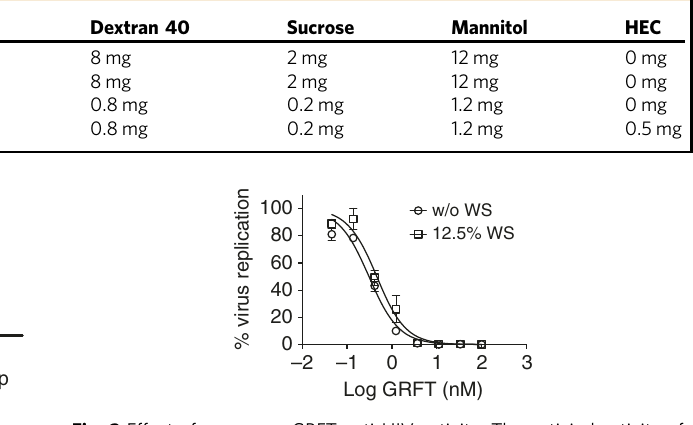
hydroxyethylcellulose (HEC) placebo FDI-treated controls (Fig. 4d). HEC was used since CG impedes HSV and HPV infections in mice 12,20,30,31 . The 63% protection vs. HEC FDI was highly signi fi cant ( p < 0.0001, Fisher ’ s exact test). Protection was associated with mean GRFT concentrations in mouse vaginal